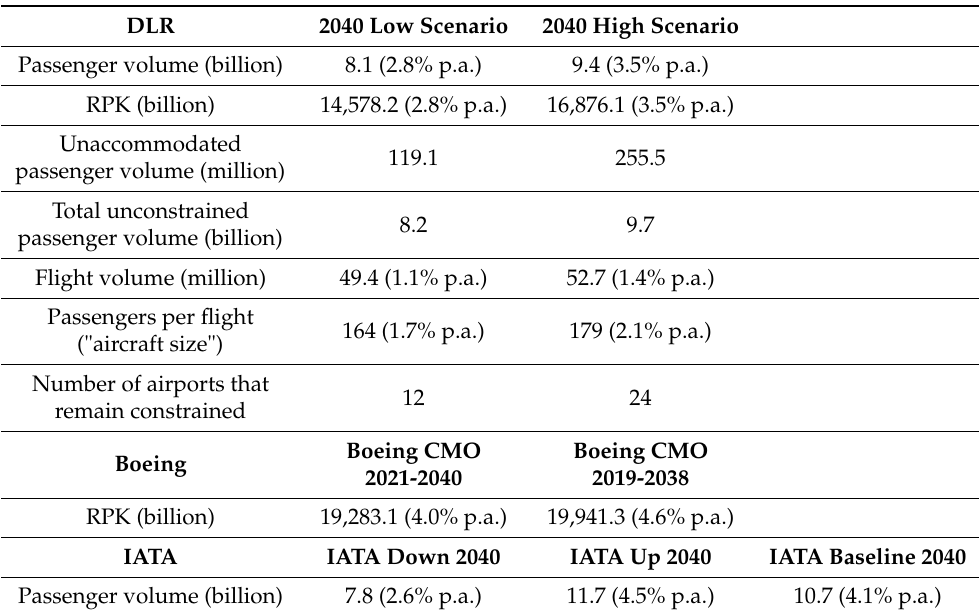
Table 1. Global forecast results for 2040 for the low and high scenario (compound annual growth rates in